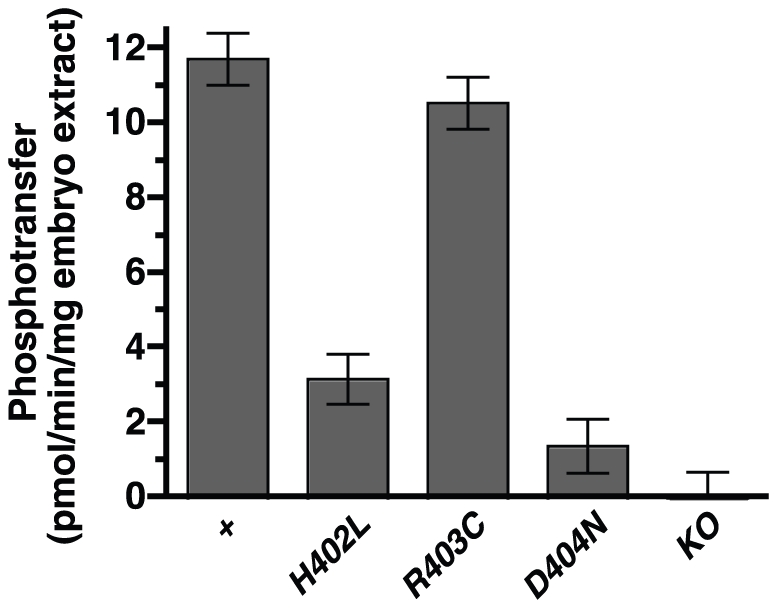
Tyrosine kinase activities of src64 HRD mutants.Phosphotransfer was measured in cellularization-stage embryo extracts. Src64-dependent phosphotransfer to a peptide substrate is shown. src64H402L, src64D404N and src64KO differ from wild type (p<0.01). Wild type, src64H402L and src64R403C differ from src64KO (p<0.01). Error bars are SEM.